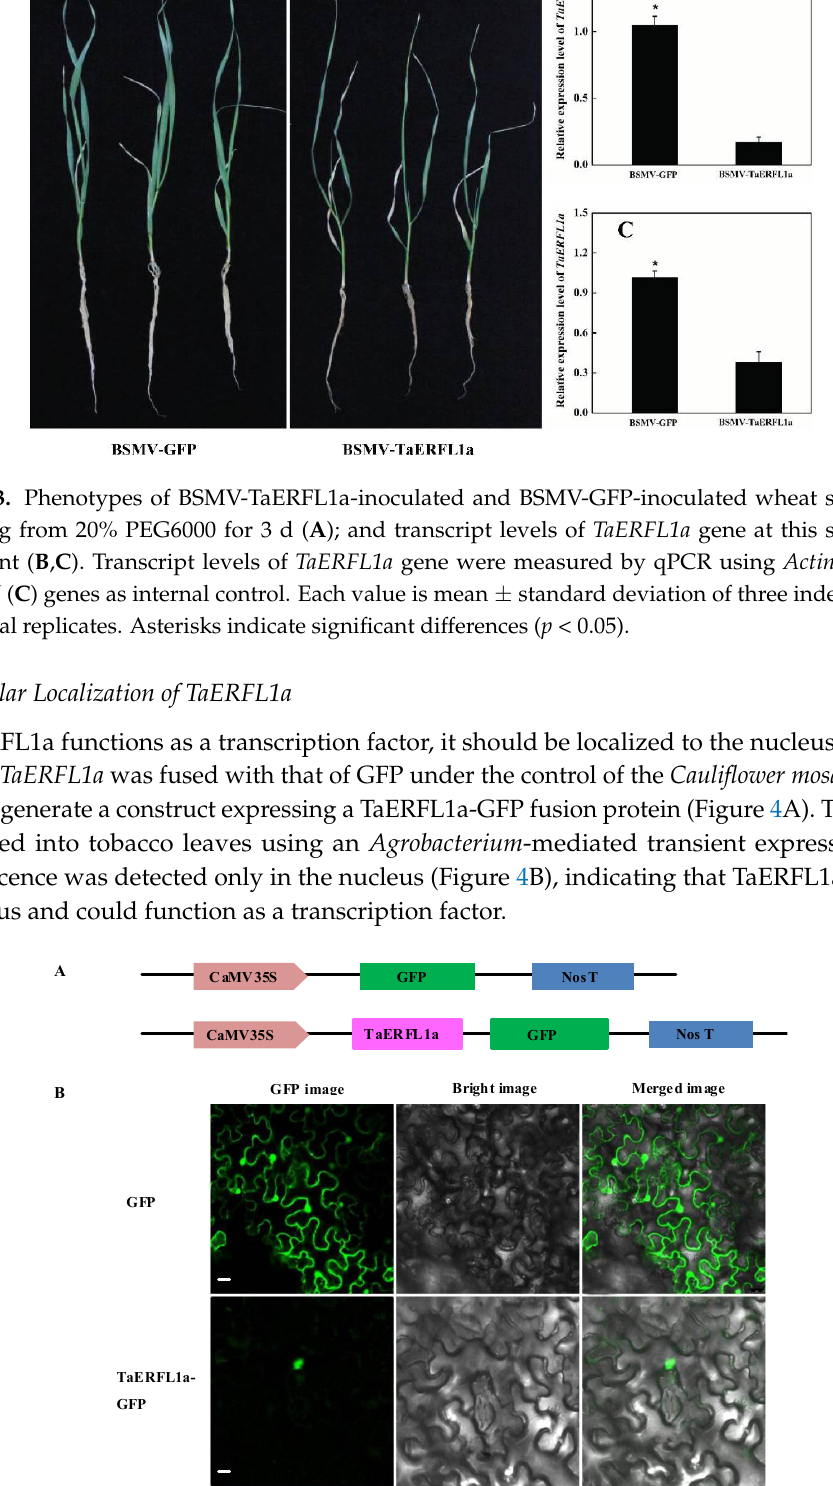
Figure 4. Subcellular localization of TaERFL1a protein in tobacco leaves: ( A ) structure of TaERFL1a-GFP fusion expression vector; and ( B ) subcellular localization of single GFP protein (GFP), and TaERFL1a-GFP fusion protein (TaERFL1a-GFP) in tobacco leaves. Bar = 20 μm.